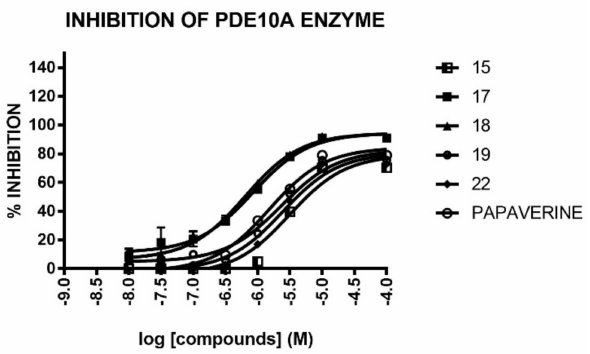
Figure 3. Dose-response curve of the most active compounds 15 , 17 , 18 , 19 , 22 and reference drug-papaverine on PDE 10A activity measured by the luminescence